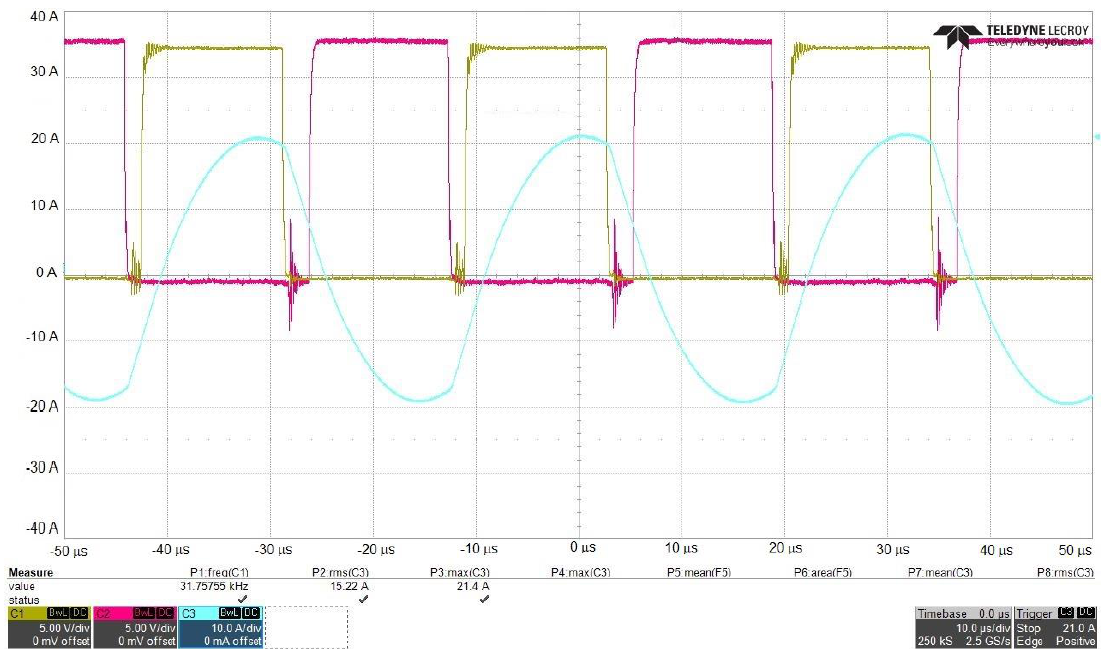
Figure 34. High-side IGBT control signal (C1, green), low-side IGBT control signal (C2, purple), and transmitter coil current (C3, blue) at 31 kHz.